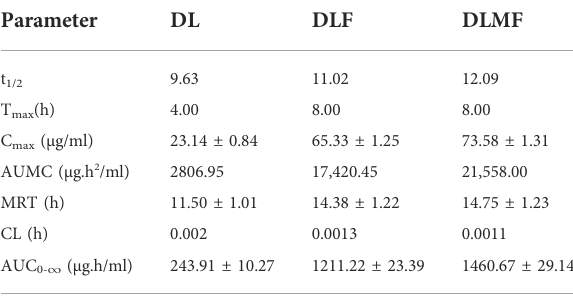
TABLE 4 Pharmacokinetic parameters of DL, DLF and DLMF in rat plasma.